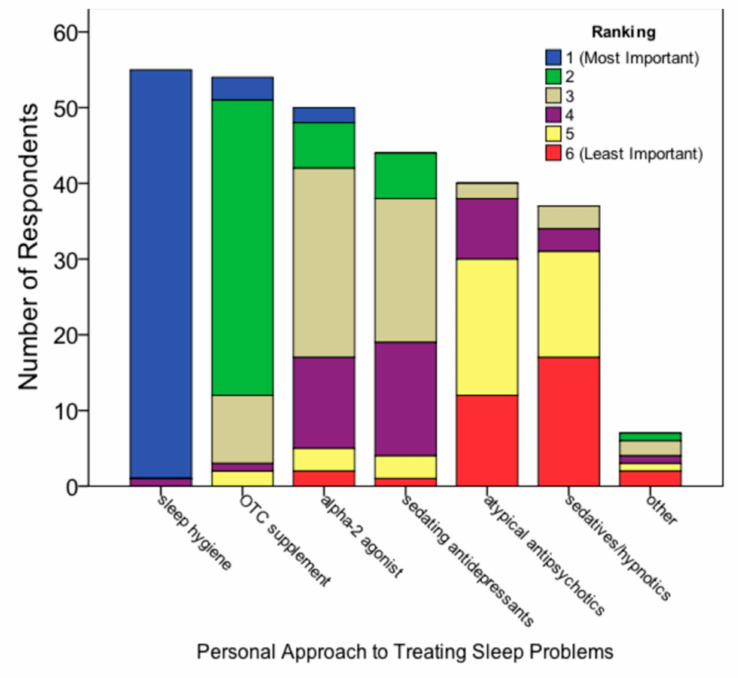
Figure 2. Ranked importance of clinical approaches to sleep